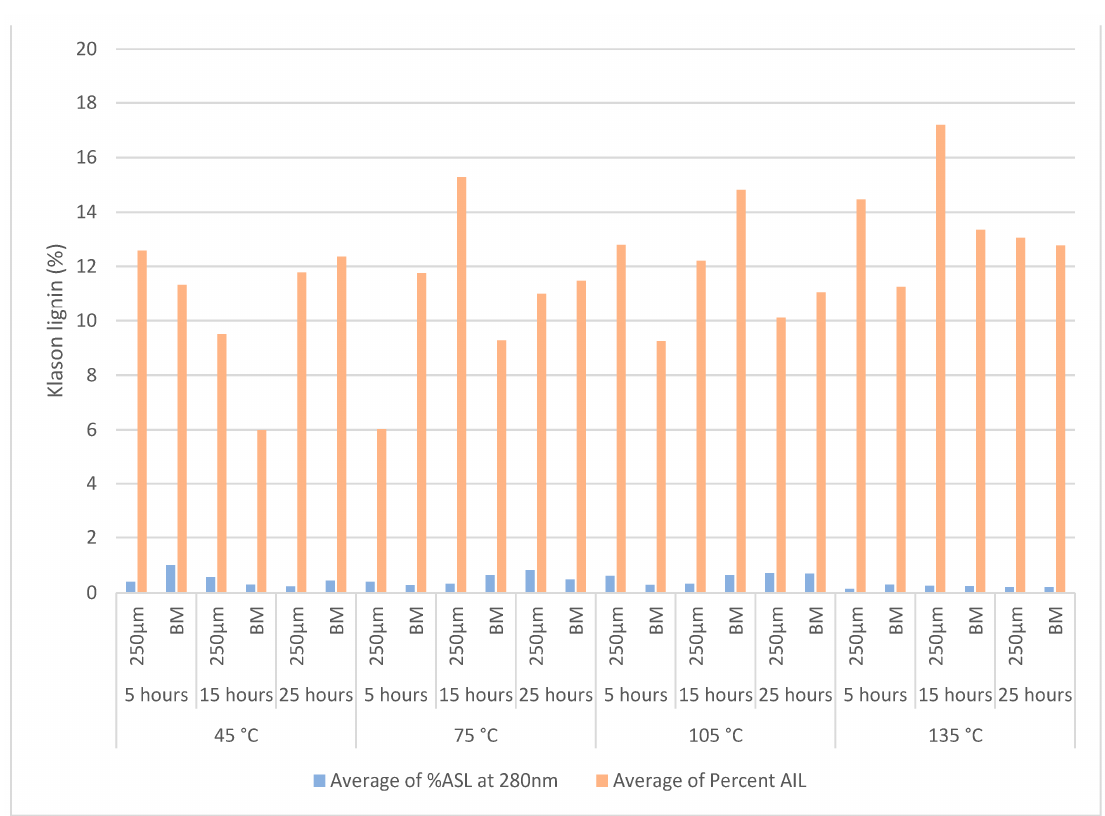
Figure 4. Klason lignin for leaf samples after pretreatment.